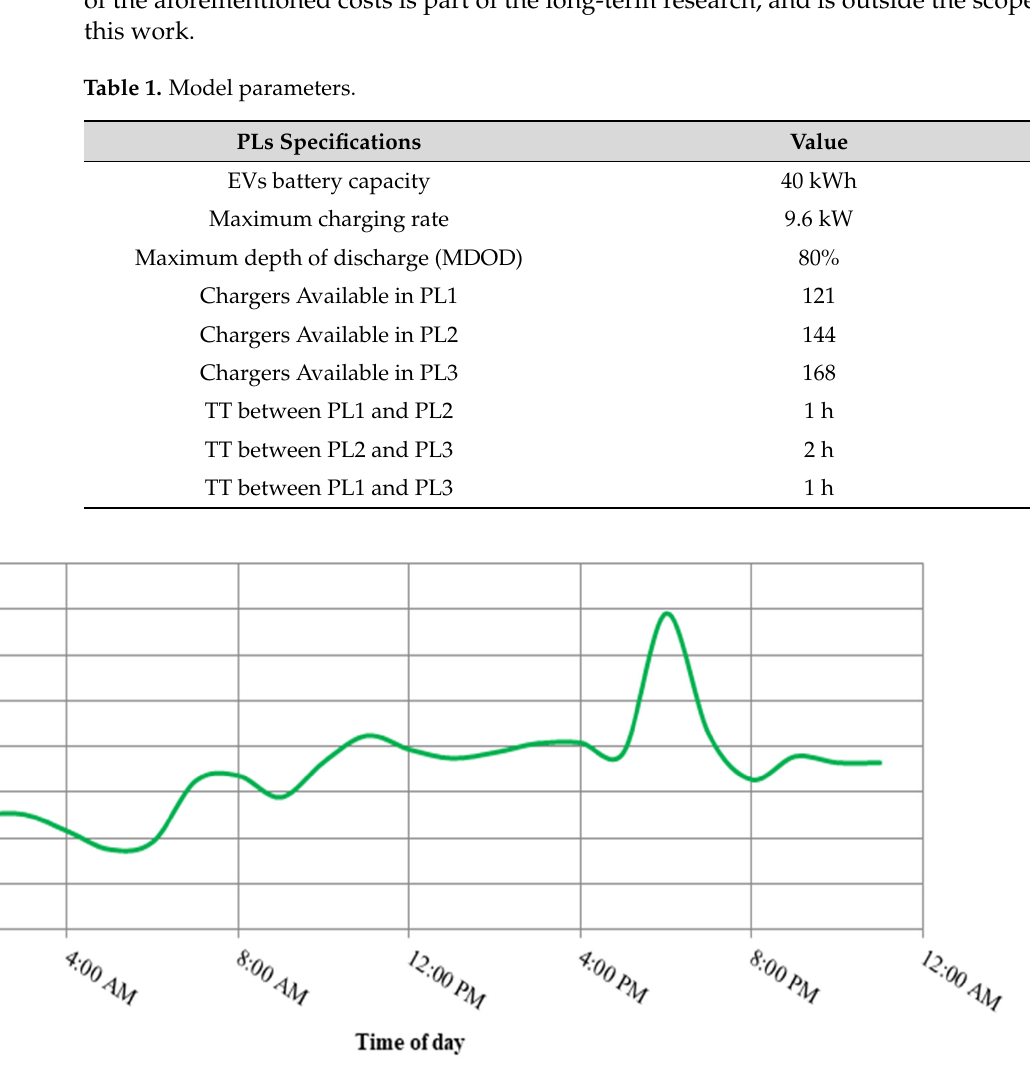
Figure 3. The 38-bus power distribution system under study.